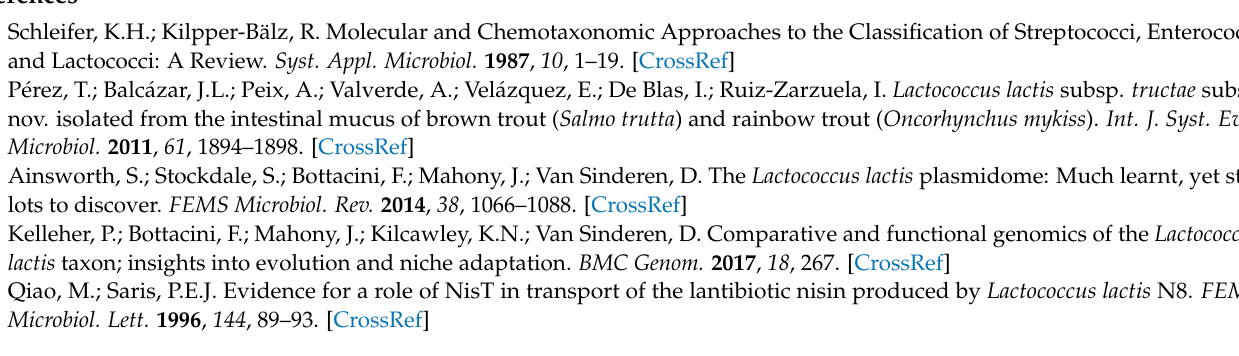
L. lactis . Supplementary Figure S2. Swiss Model prediction results of YujF. Supplementary Table S1. Primers used in this study. Supplementary Table S2. All 202 L. lactis data retrieved by latest 5th July 2021. Supplementary Table S3. Script for converting GFF files to GFF3 files. Supplementary Table S4. Prophage prediction results on 42 L. lactis strains with complete genomes currently published by NCBI. Supplementary Table S5. The detailed information of 12 GIs. Supplementary Table S6. Secondary metabolite biosynthetic gene cluster prediction results of 43 L. lactis strains (including L. lactis N8) with complete genomes currently published by